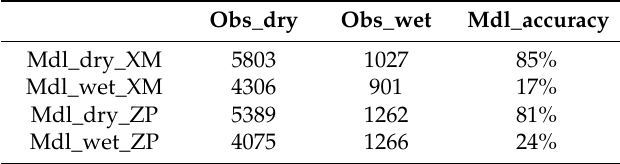
Table 3. Rainfall occurrence (XM and ZP), ERA-5 (European Centre for Medium-Range Weather Forecast Reanalysis-5).